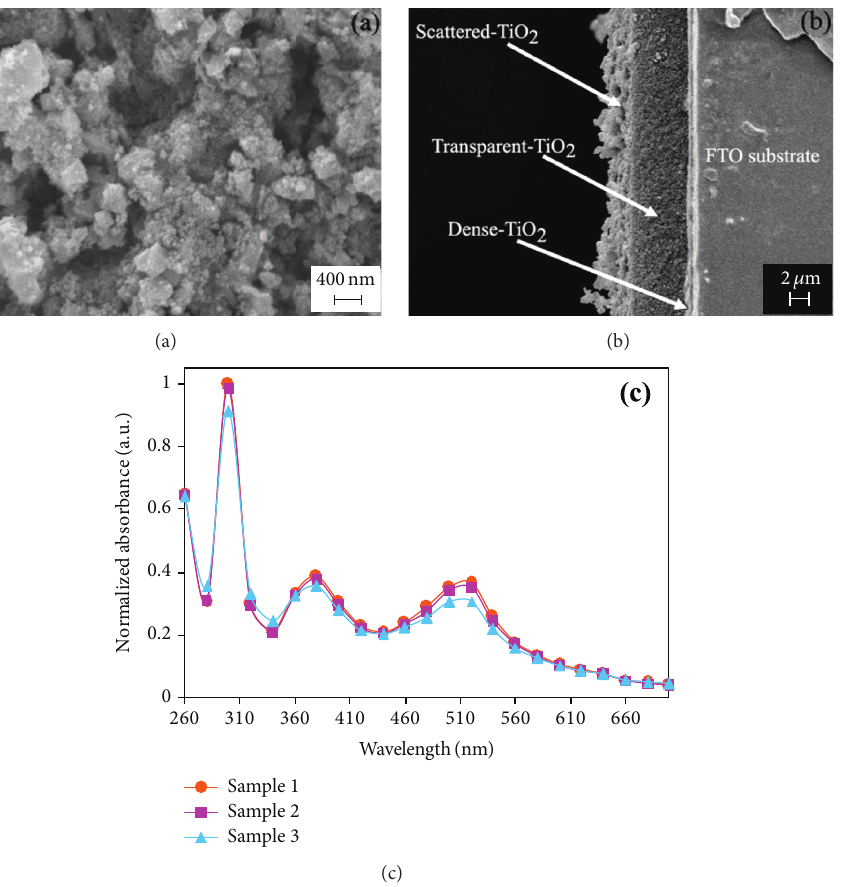
Figure 2: (a) The top and (b) cross section SEM images of TiO 2 film on FTO glass. (c) The absorbance spectra of the desorbed dye solutions of the TiO 2 /FTO films.